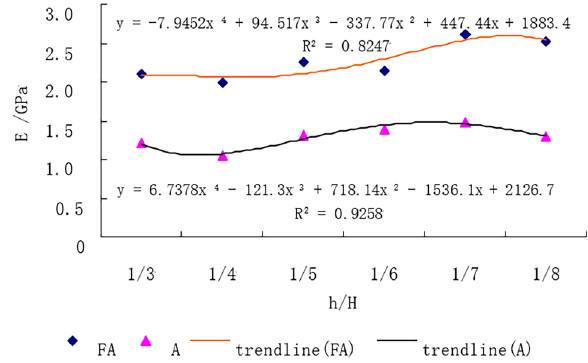
Figure 13. Elastic modulus of composite rock specimens.